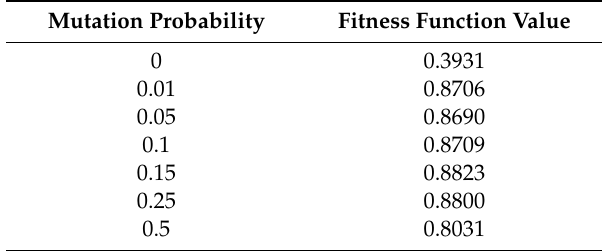
Table 5. Optimization results for di ff erent mutation